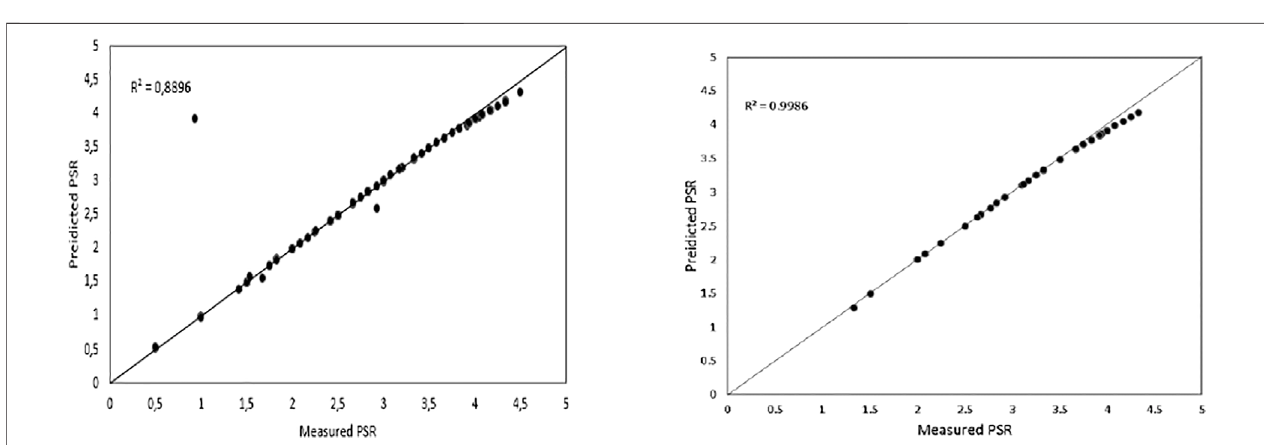
FIGURE 8 | Correlation scheme of predicted PSR against PSR for training and testing data.